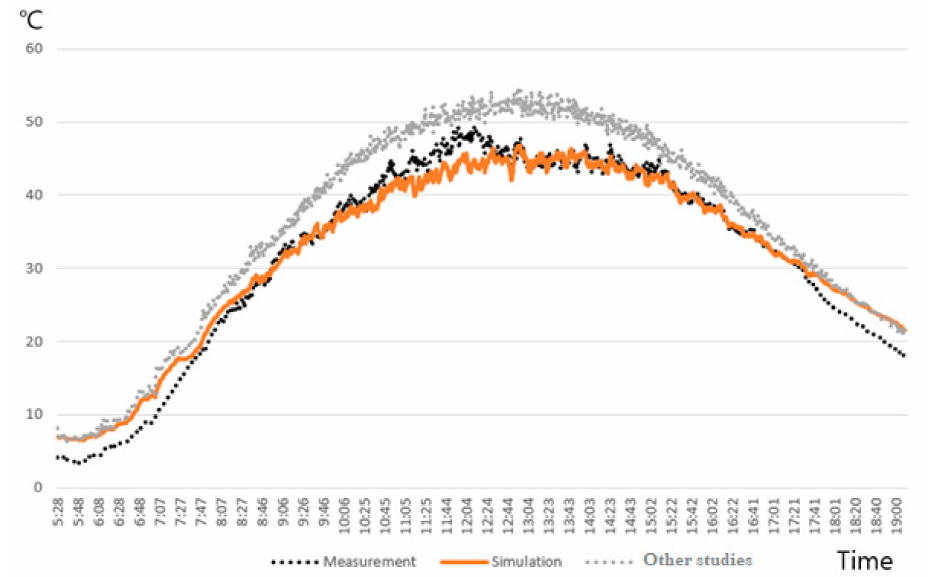
Figure 7. Graph showing the results of the current study and that of other studies. Instances of substantial error are found in previous research